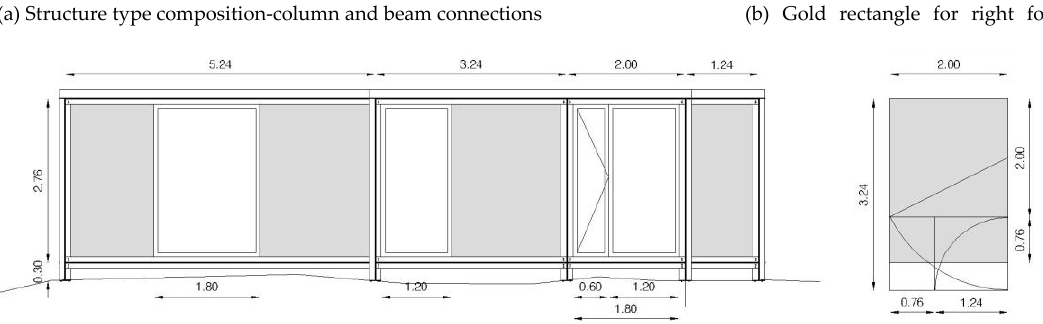
Designs 2020 , 4 , x FOR PEER REVIEW Figure 6. Composition of the modules-elevation (connection between columns and beams).